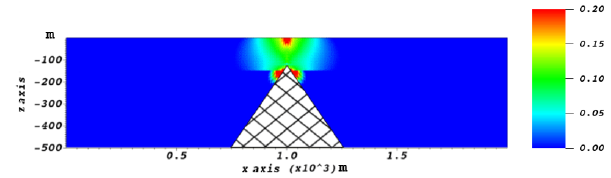
Figure 3. Ratio of simulated normal stress to the pressure change.